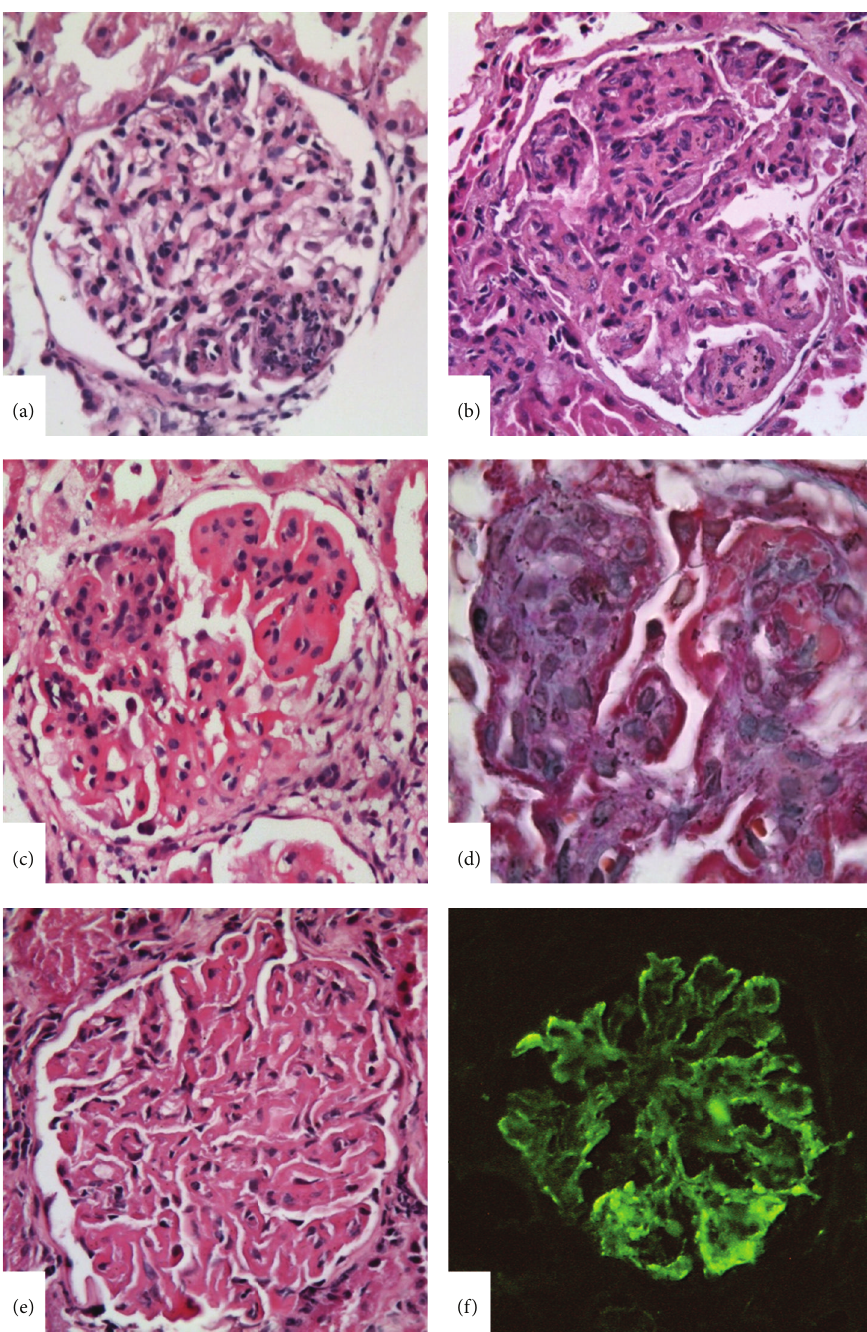
Figure 4: Lupus nephritis class IV. (a) Class IV-S case with segmental endocapillary proliferation. The lesion was diffuse in the biopsy (not shown in the picture). (b) Global endocapillary proliferation with leukocyte infiltration. (c) Endocapillary proliferation with widespread wire loop appearance in the glomerular capillary wall indicator of subendothelial immune deposits by light microscopy. (d) Reflection of the subendothelial deposits as fuchsinophilic deposits in Masson Trichrome stain. (e) Global wire loop appearance without mesangial or endocapillary cellular proliferation. This finding was diffuse in the biopsy (not shown in the picture). (f) Significant immune deposit overload in glomerular capillary wall by IFM ( ×